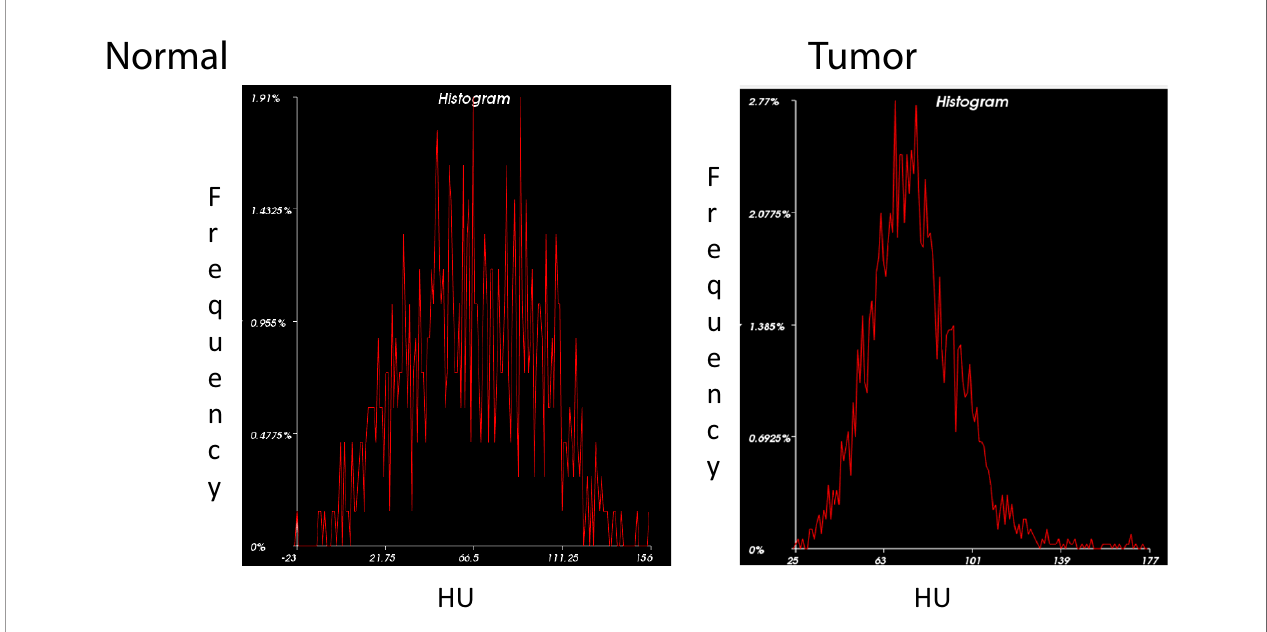
FIGURE 4 | Histogram Analysis of Normal Pancreas vs . PDAC. Histogram distribution of the normal pancreas (left) shows greater variation in density representative of its heterogeneous echotexture compared to a more homogenous pattern in PDAC